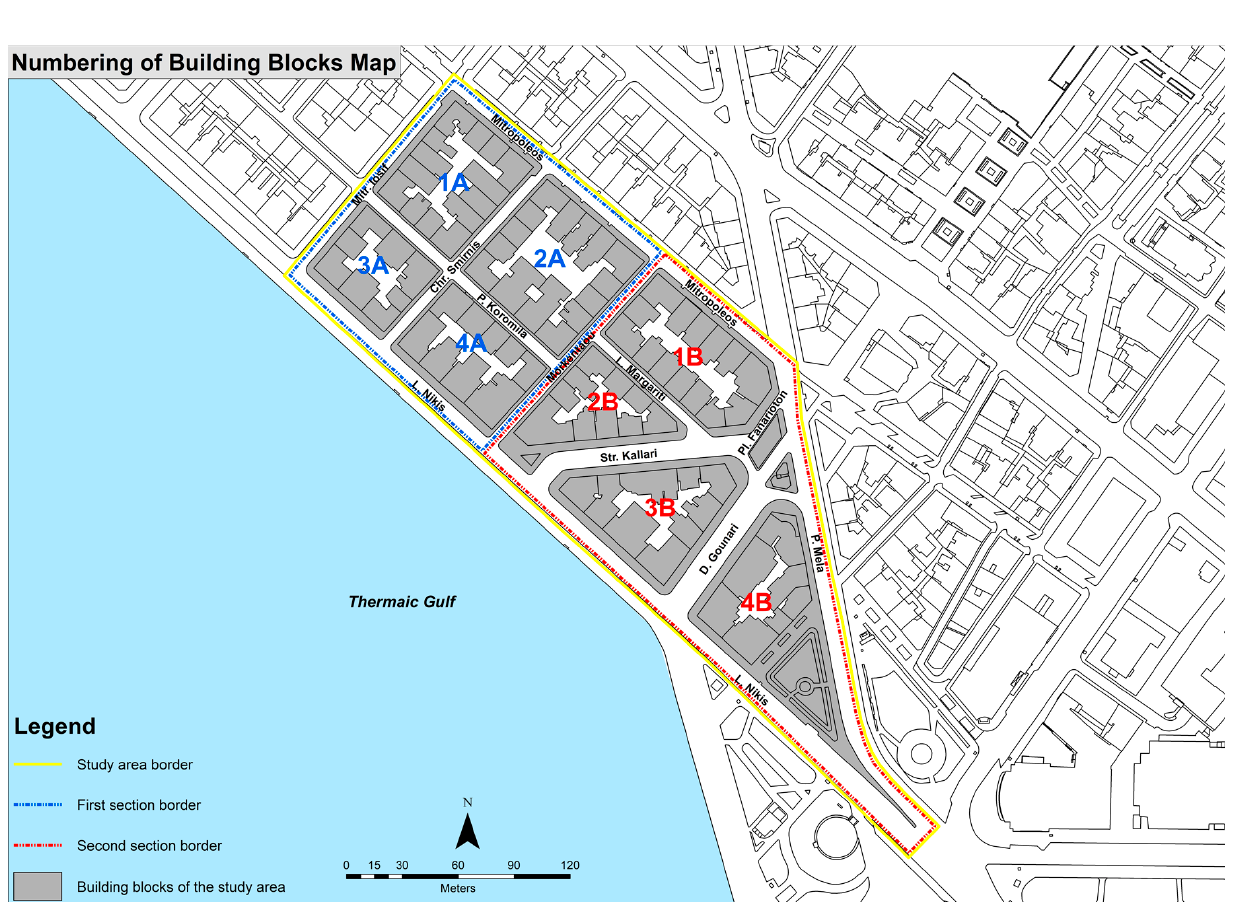
Figure 6. Numbering of building blocks of the study area, ArcGIS